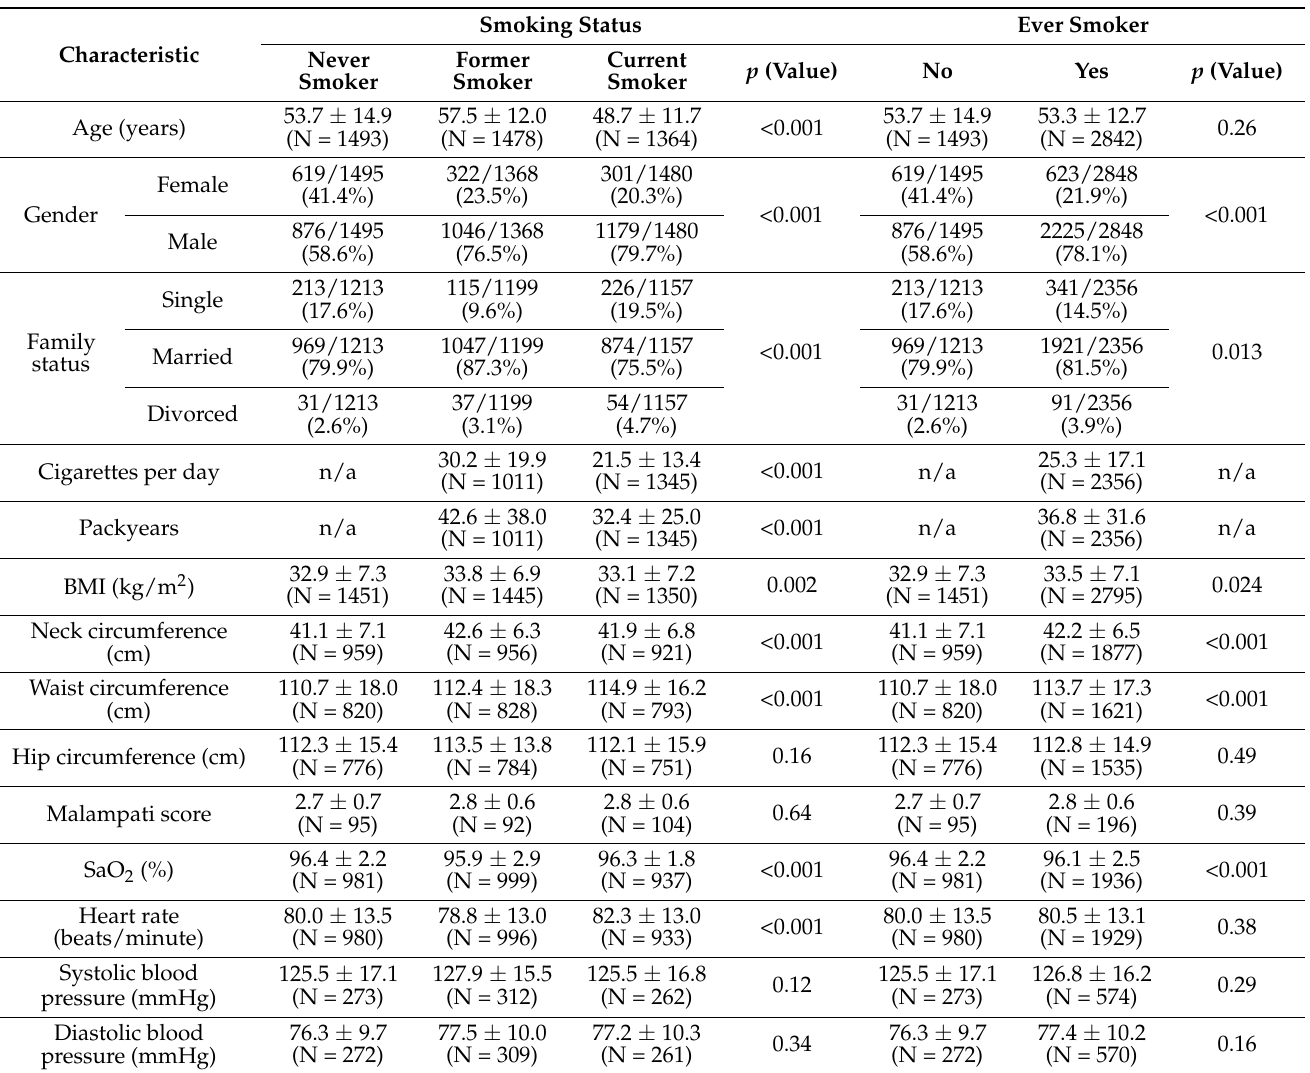
Table 1. Baseline